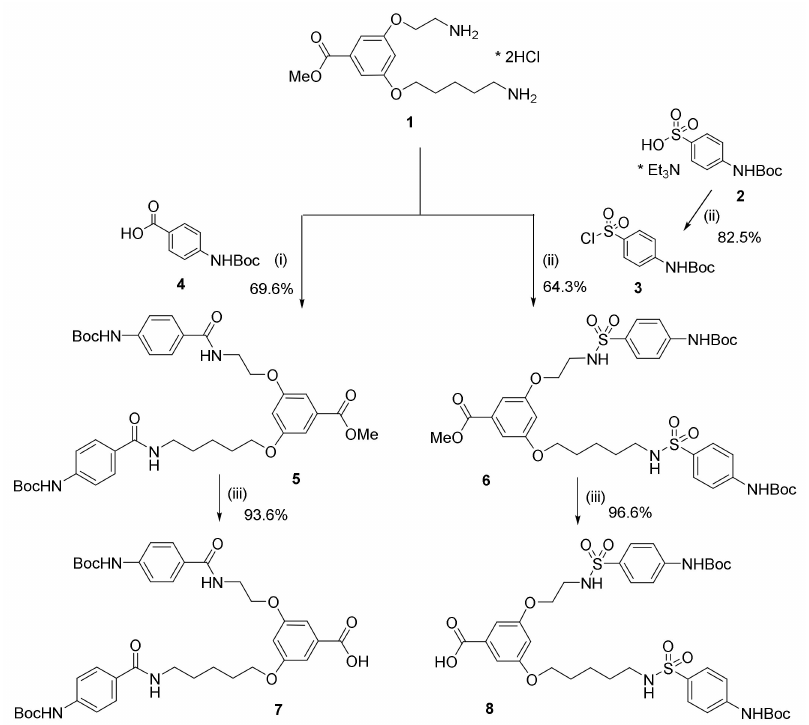
Scheme 1. Synthesis of the right side organic dendrons 7 and 8 with two PABA ( 7 ) or PAS ( 8 ) residues constituting right side of the bola structure starting from substrate 1 (synthesis of 1 described in ref. [17]). Conditions: ( i ) EDC/HOBt, Et 3 N, DMF, 96h; ( ii ) EDC/HOBt, Et 3 N, CH 2 Cl 2 /DMF, r.t.; 48 h; ( iii ) (1) 1M NaOH, MeOH, 50 ◦ C; (2) 1M